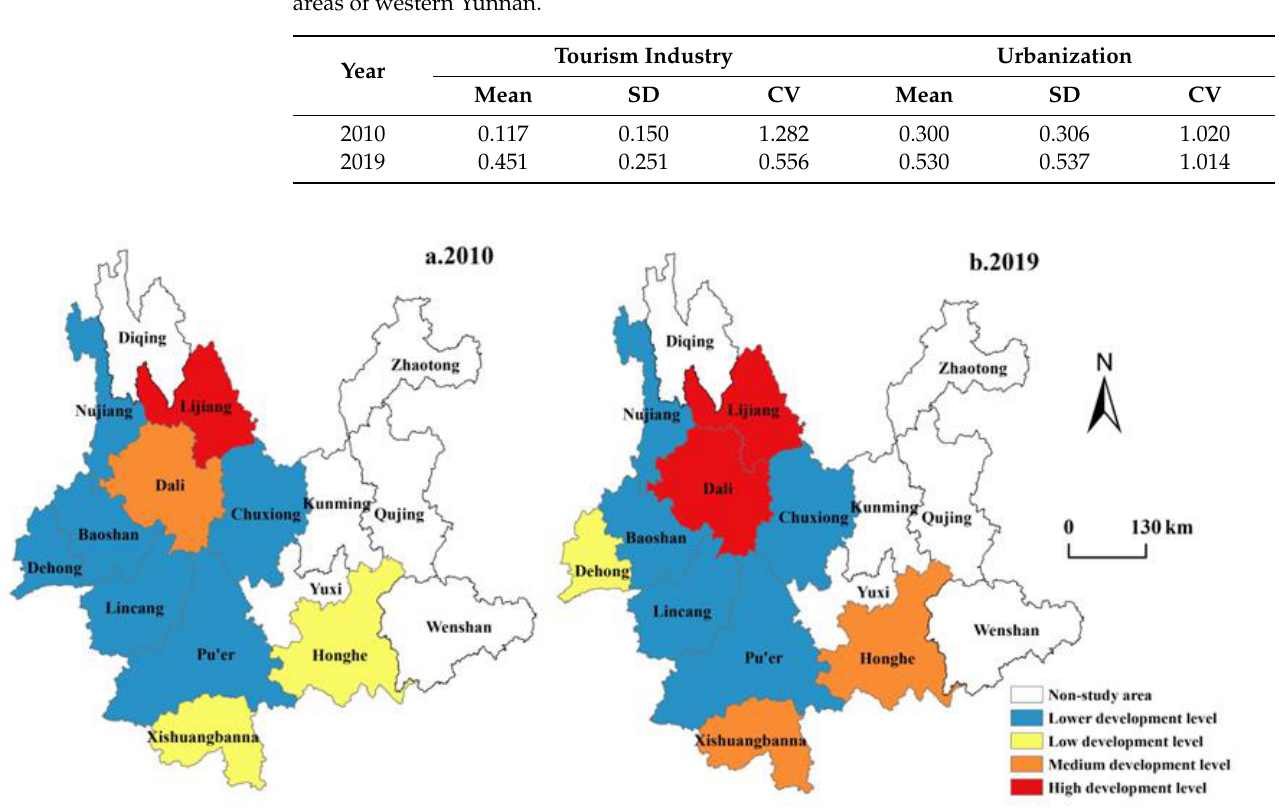
Figure 3. The spatial distribution of tourism industry development levels in the mountainous border areas of western Yunnan.